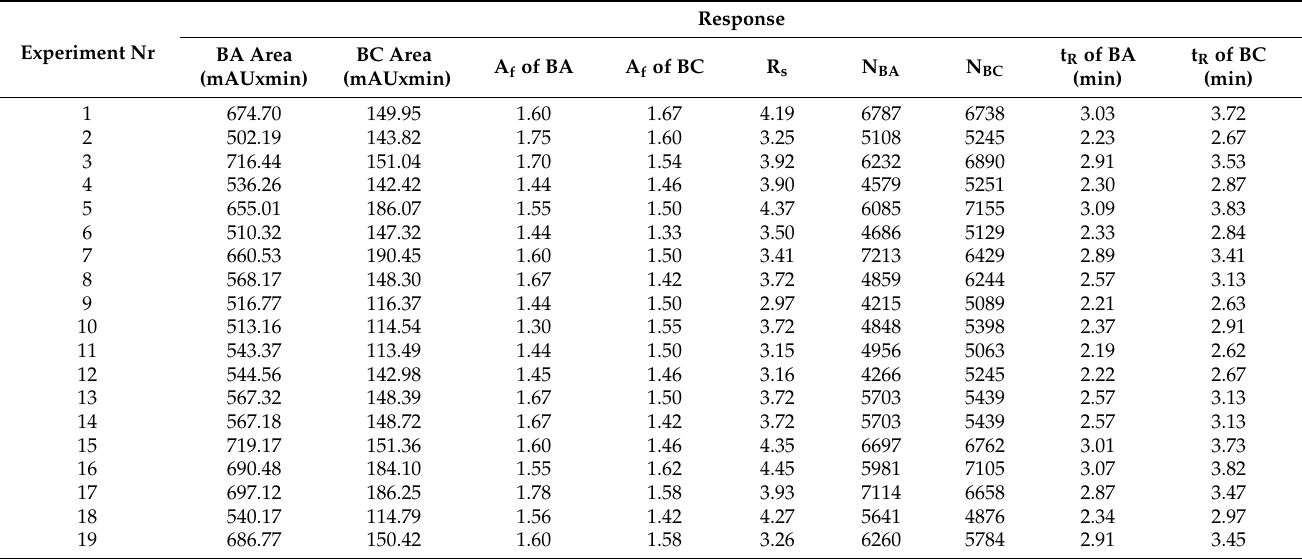
Table 3. Values of the responses per the FFD